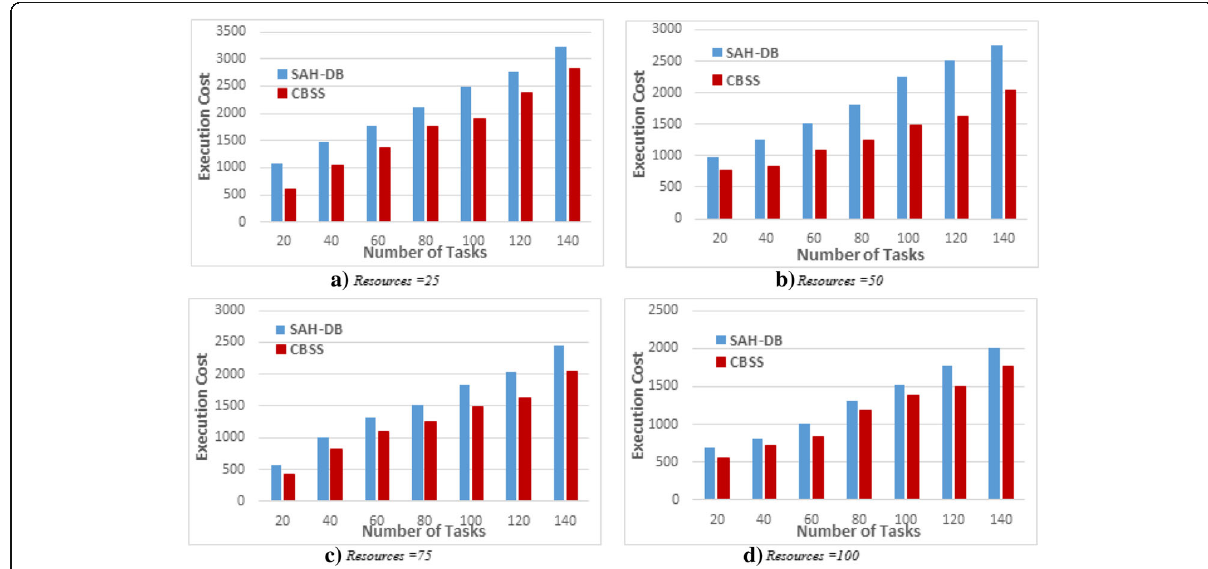
Fig. 9 The execution cost with different